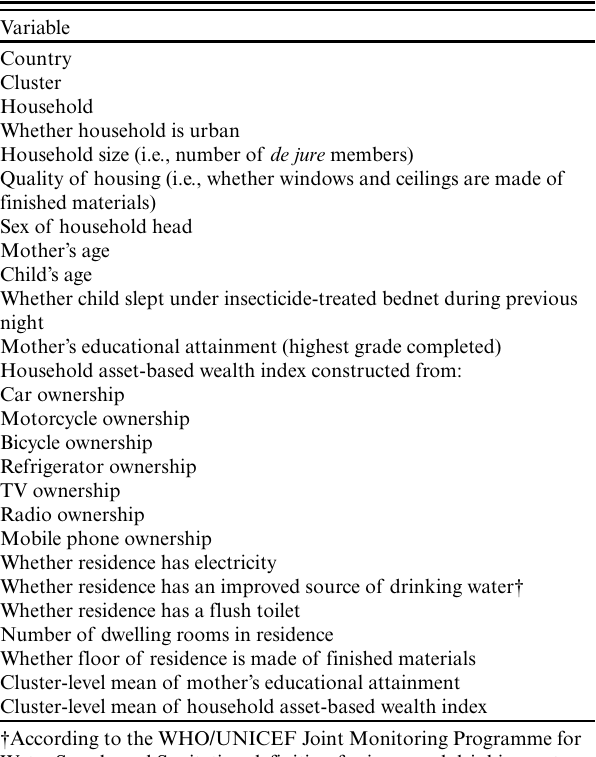
Table 2 . Contextual, household, and individual variables retained.